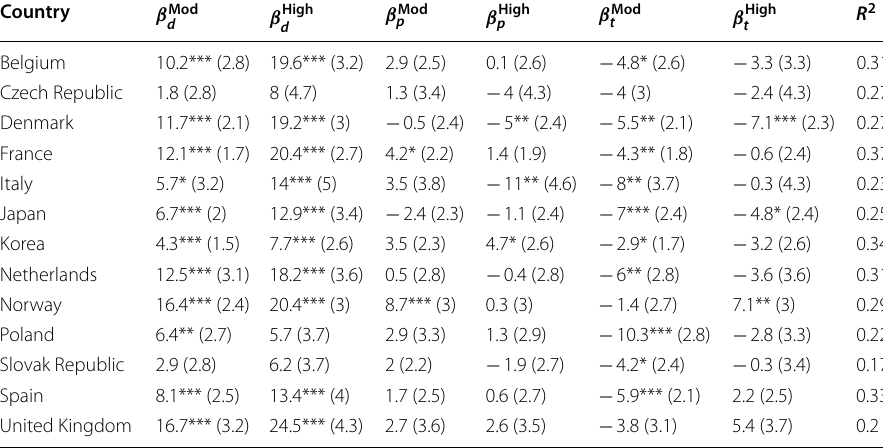
β Mod d and β High d : estimate of moderate and high data complexity. β Mod p and β High p : estimate of moderate and high people complexity. β Mod t and β High t : estimate of moderate and high things complexity. Reference category is low complexity. Standard errors in parentheses *, **, *** refer to significance at the .1, .05, and .01 levels,